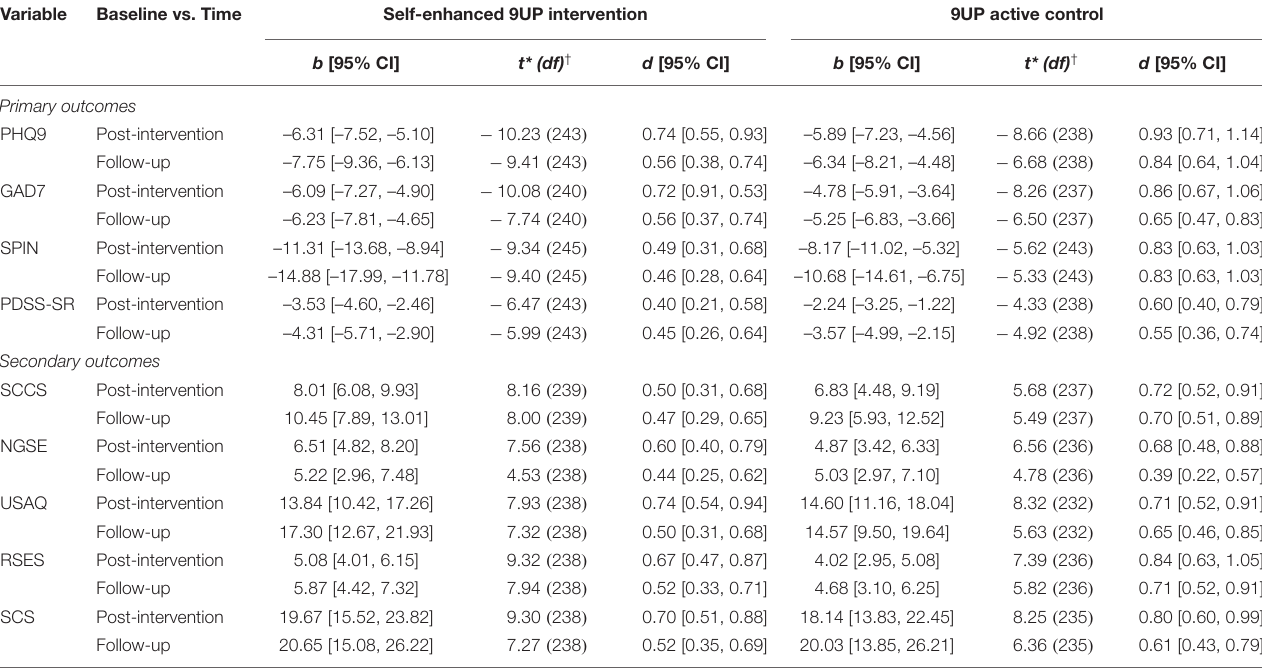
TABLE 4 | Estimates of mean differences between baseline and post intervention, respectively, follow-up (within-group effects). Variable Baseline vs.